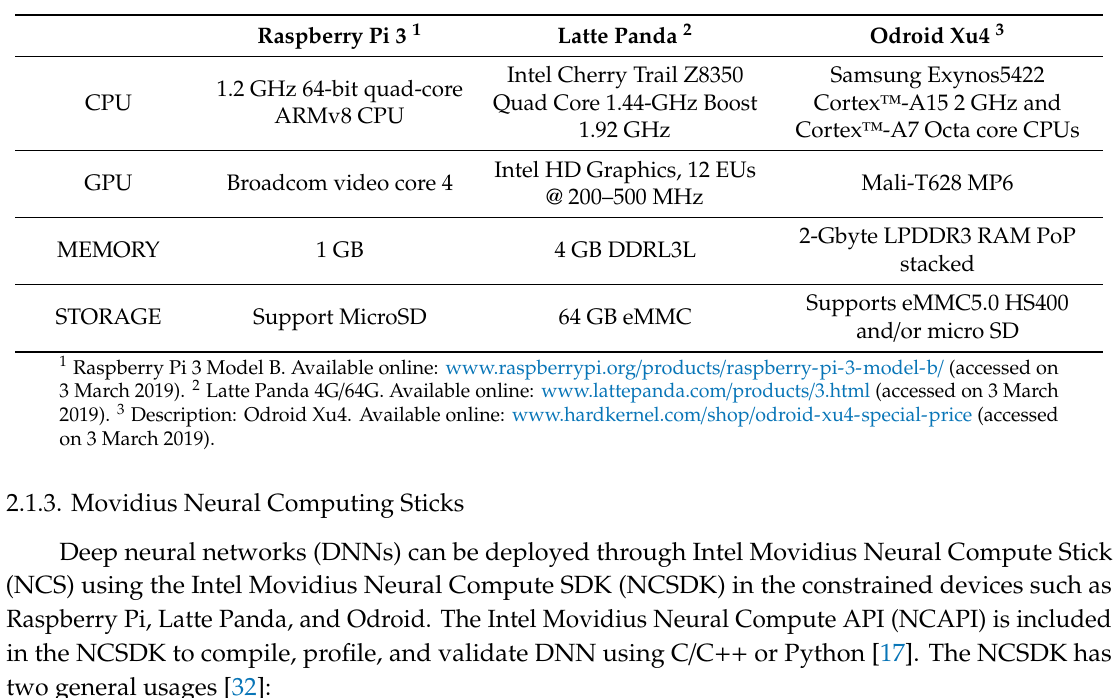
Table 3. Basic comparison between Raspberry Pi 3, Latte Panda, and Odroid